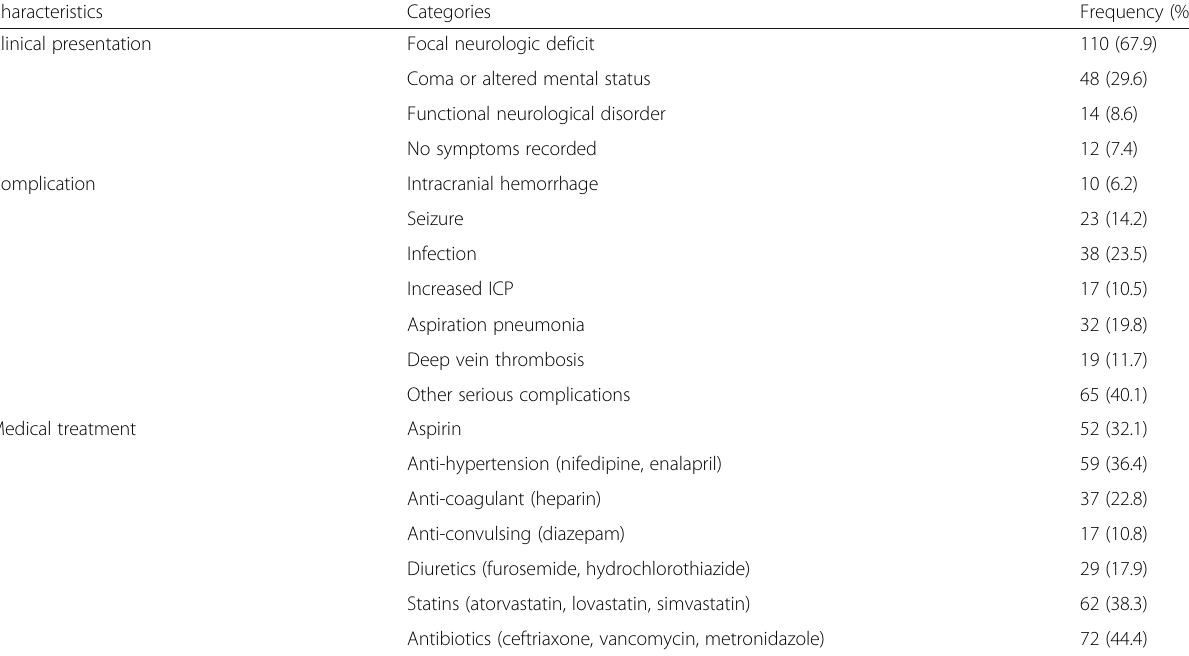
Table 4 Clinical presentations, complications, and medical treatment of stroke in Debre Markos Referral Hospital, Northwest Ethiopia,